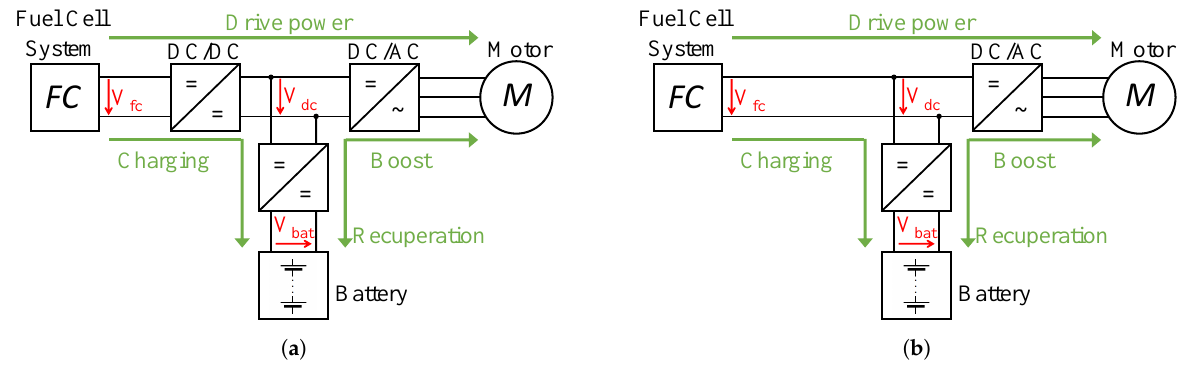
Figure 2. Electric architectures for FCHVs: ( a ) electric architecture with a boost converter for the fuel cell system; ( b ) electric architecture without a boost converter for the fuel cell